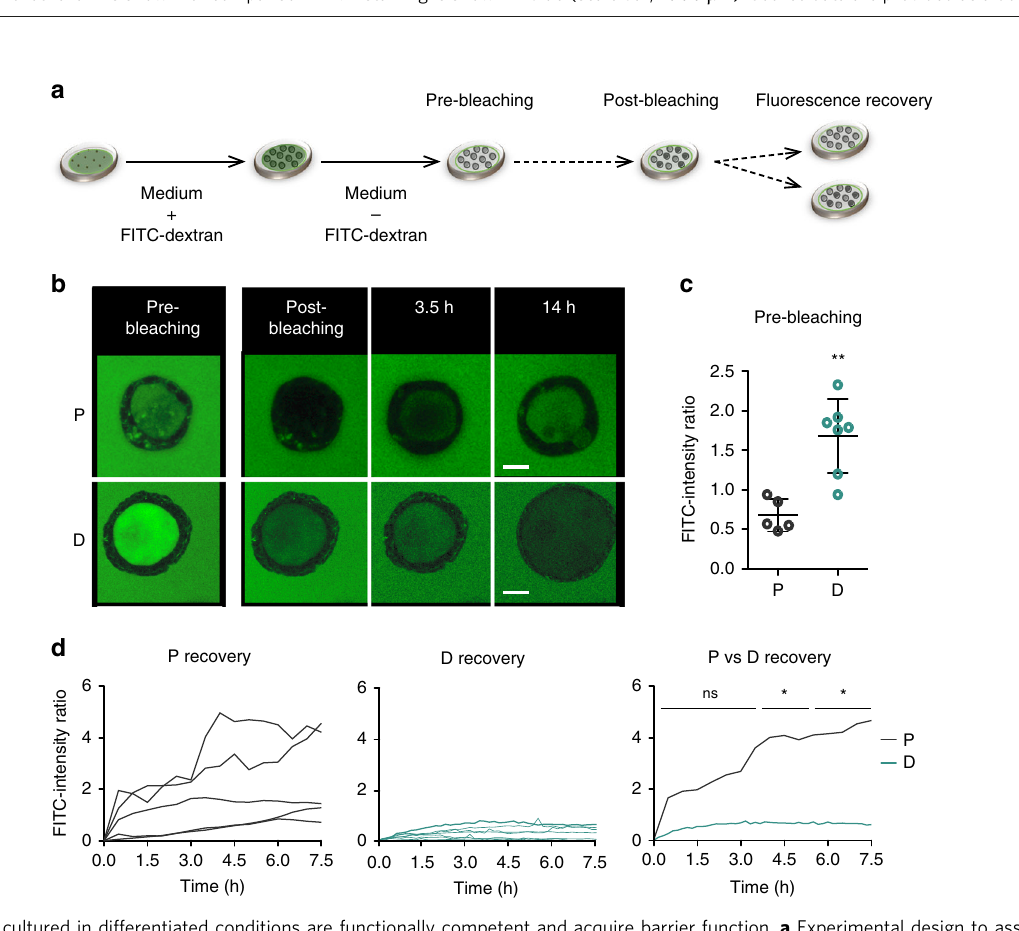
Fig. 2 Growth factor-depleted organoids recapitulate the urothelial differentiation program. a Experimental design applied to induce urothelial organoid differentiation: organoids cultured until day 7 in complete medium were maintained for seven additional days in differentiation medium. b Image of organoids displaying the features quanti fi ed in panel c : d , diameter; l, lumen; t , thickness of the epithelial layer. The signal distribution was measured across the organoids as indicated by the arrow in both cases (scale bar, 100 μ m). c Signal distribution (in microns) acquired by confocal microscopy displaying the quanti fi cation of organoid features (diameter) of individual proliferative (P) (n = 57) and differentiated (D) ( n = 71) organoids; color code indicates the intensity of the signal: green, low; yellow, intermediate; red, high. d Violin plots representing organoid features. e RT – qPCR analysis of expression of genes regulated during differentiation. Data are normalized to Hprt expression (Mann – Whitney test, error bars indicate SD). f Western blot (WB) analysis showing expression of TP63 (basal marker), UPK3a, and UPK1b (luminal markers) in P and D organoids in three independent experiments. Urothelial bladder cancer cell lines (ScaBER, RT112, VMCUB1, and RT4) were used as controls. g Immuno fl uorescence analysis of urothelial markers in P and D organoids. Normal urothelium is shown for comparison. DAPI staining is shown in blue (scale bar, 1000 μ m). Source data are provided as a Source Data fi le